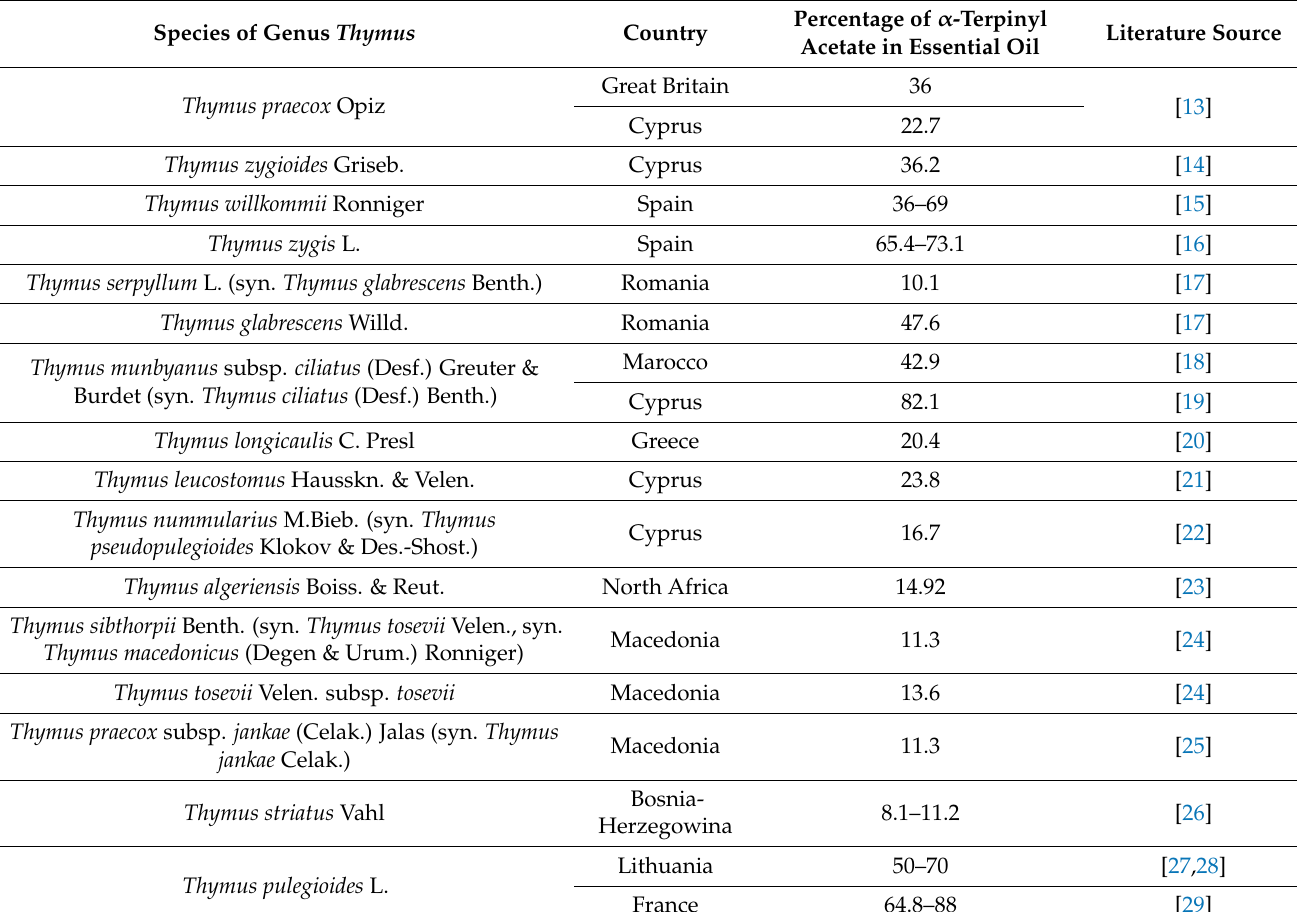
Table 1. Percentages of α -terpinyl acetate in essential oils of different species of genus Thymus. Species of Genus